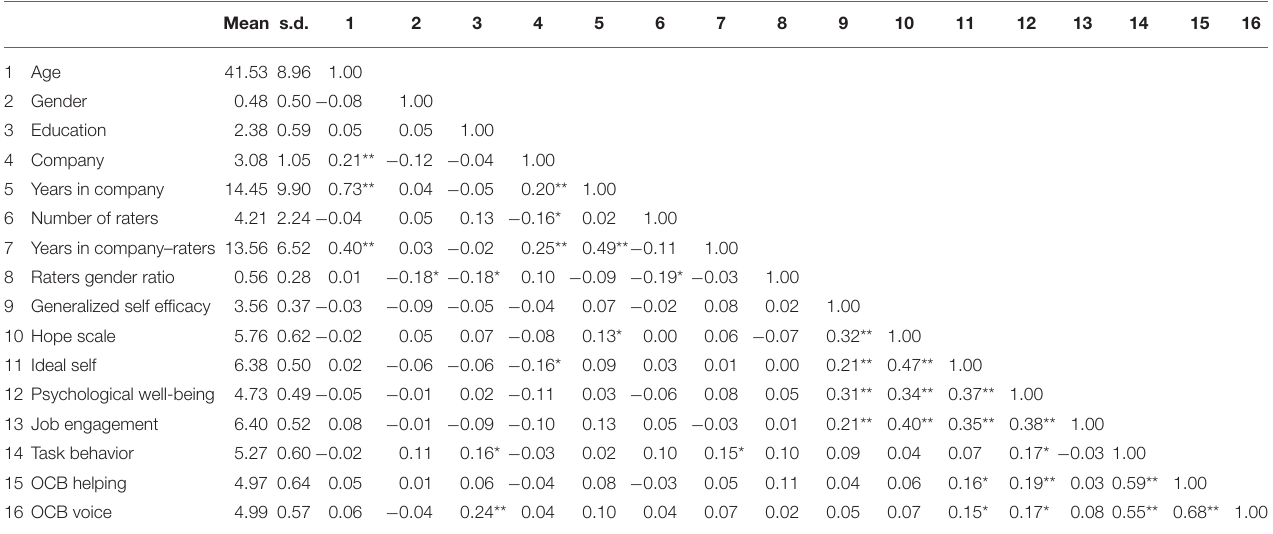
TABLE 1 | Summary statistics and correlations. Mean s.d.